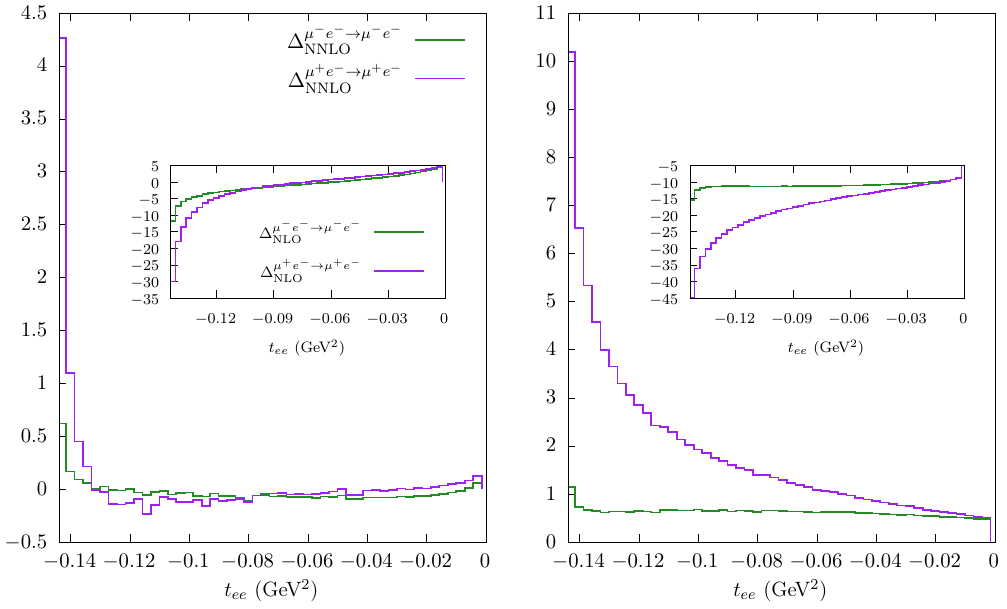
Figure 10 . The same as (cid:12)gure 9 for the squared momentum transfer measured along the electron line, t ee